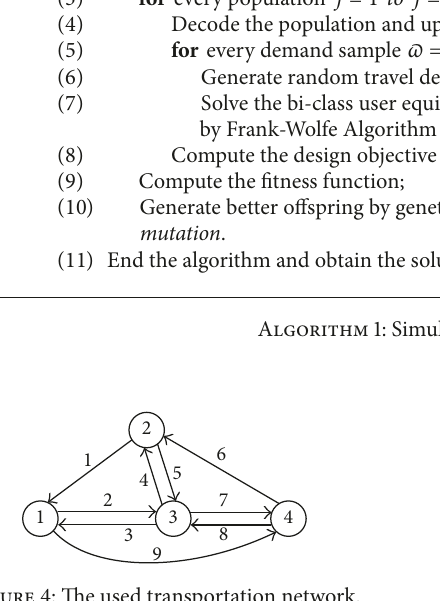
Figure 4: The used transportation